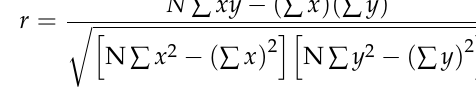
Figure 20. Relationship between aerodynamic noise and W 2 and W 4 . ( a ) Surrogate model between aerodynamic noise and W 2 and W 4 ; and ( b ) projection of aerodynamic noise on the W 2 – W 4 plane.